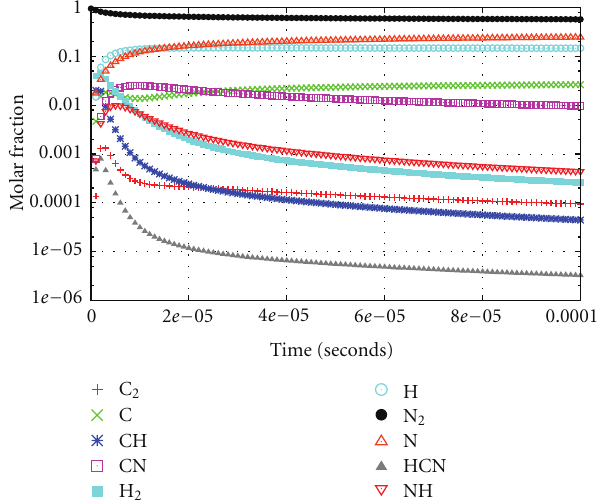
Figure 3: Neutrals-G¨okc¸en’s